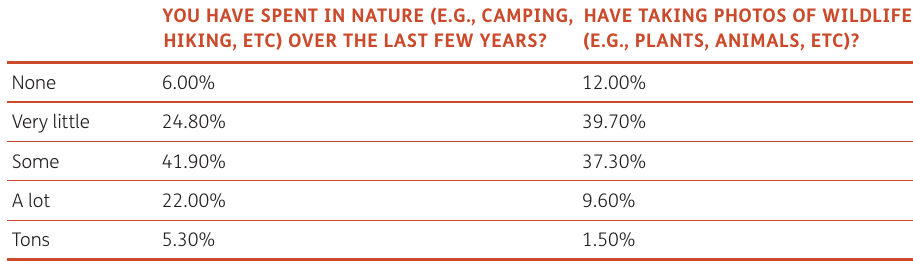
Table 1 Pre-survey results: Most students had some or very little prior experience with nature.